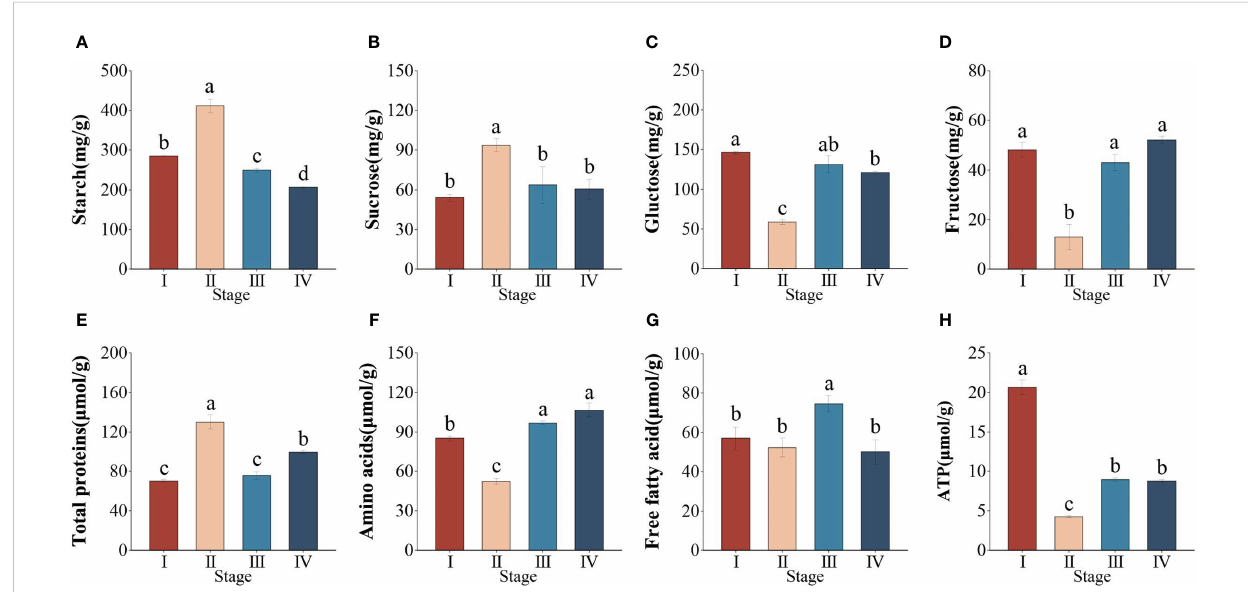
FIGURE 2 Changes in the content of energy metabolism metablites during different developmental stages in Zostera marina seeds. (A) Starch, (B) sucrose, (C) glucose, (D) fructose, (E) total proteins, (F) amino acids, (G) free fatty acids, (H) ATP. Values are the means ± standard deviation (n = 3). Different letters represent signi fi cant differences ( P <